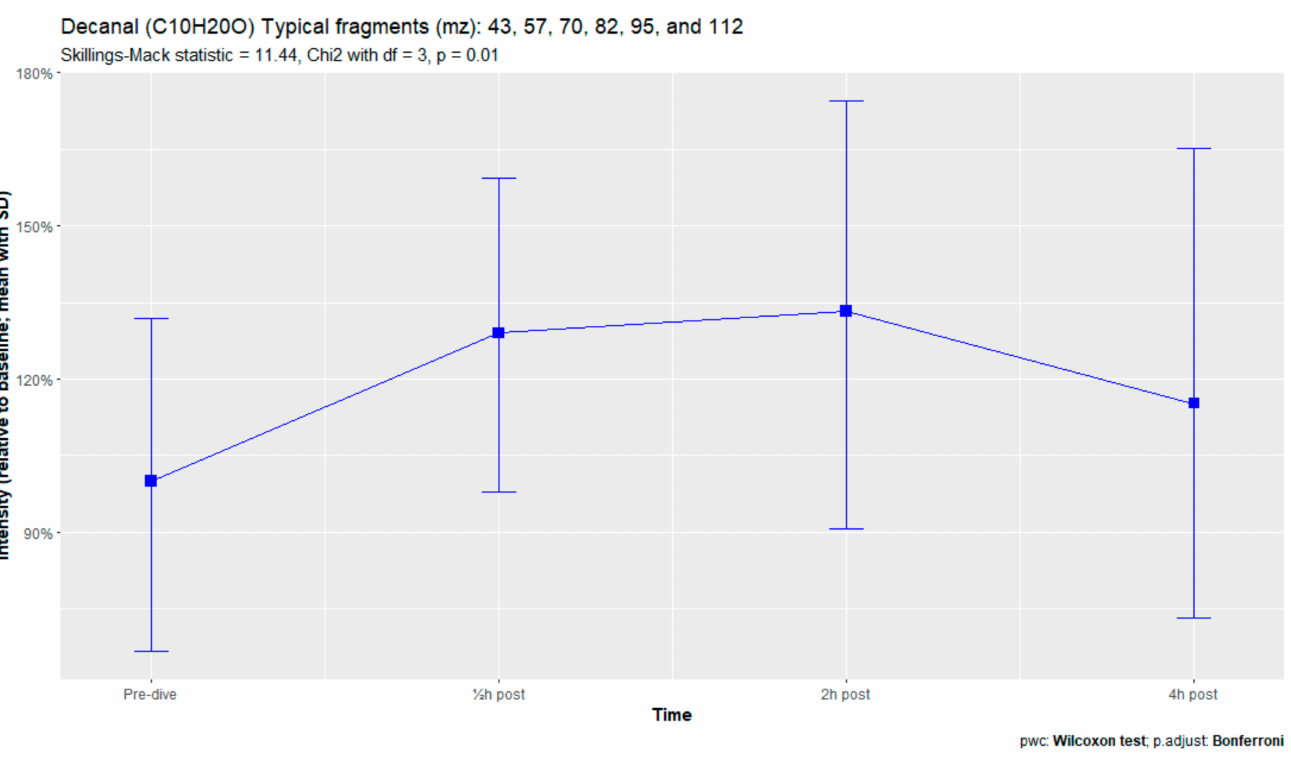
Figure A5. Decanal.